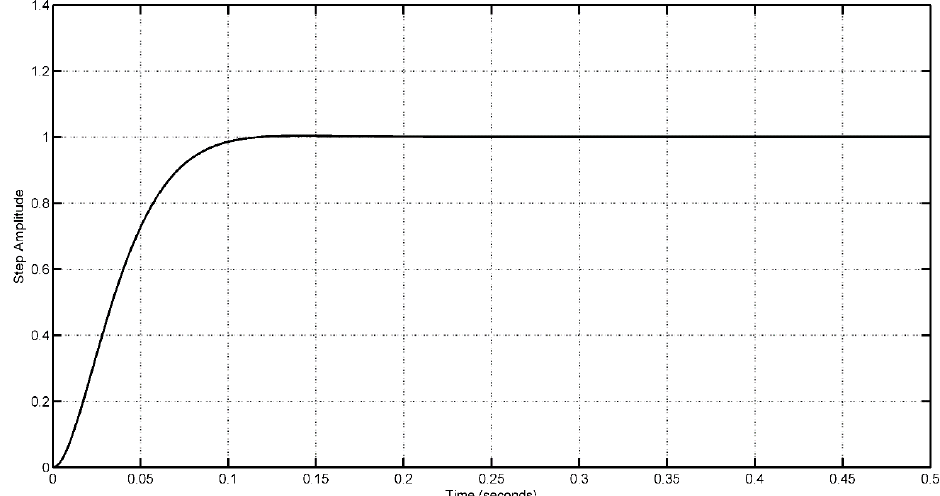
Figure 14. Pitch response of the octocopter with the designed PD controller.